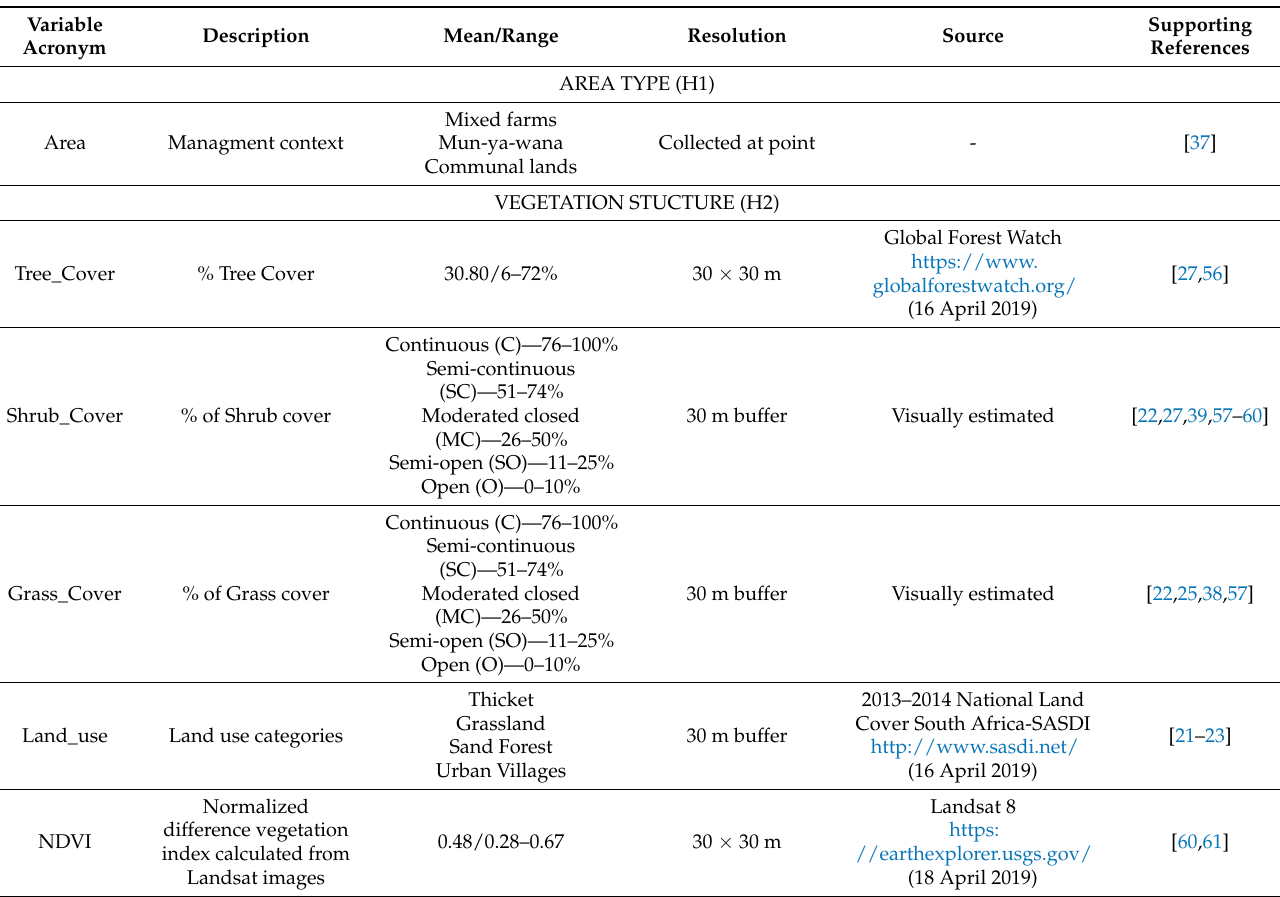
Table 1. Environmental variables used in the modeling procedure used to assess the determinants of rodent abundance, collected in the field, from camera-trapping or based on remote-sensing data (GIS-based variables). The variable description, acronym, range, resolution and source, as well the reference that support their influence on rodent presence/abundance, are listed. H1—Hypothesis 1; H2—Hypothesis 2; H3—Hypothesis 3, H4—Hypothesis